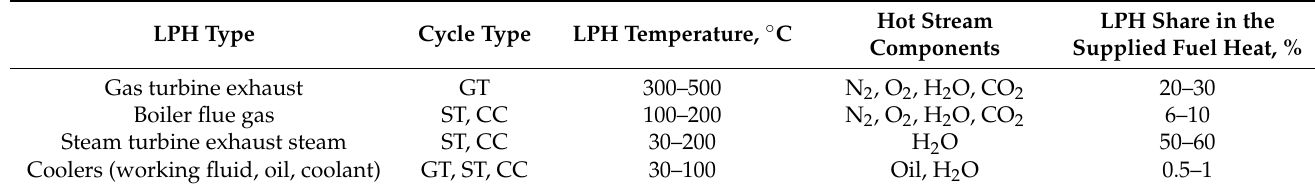
Table 1. Characteristics of low-potential heat sources in the power